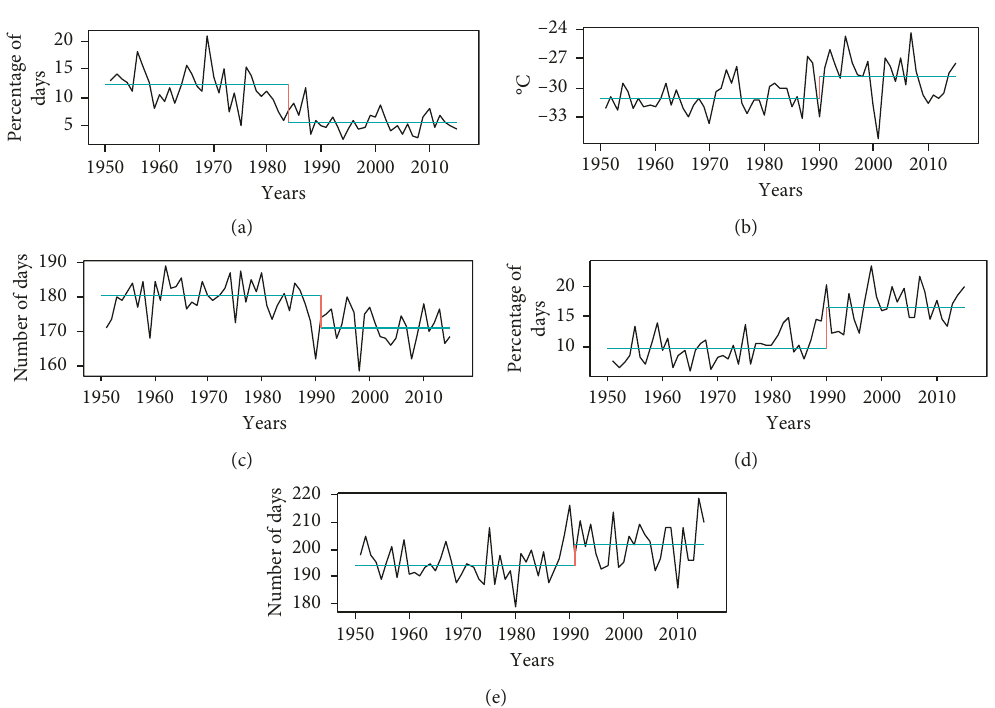
Figure 6: Annual changes of extreme temperature indices in Northeast China. (a) Cold night frequency (TN10p). (b) Annual minimum value of daily minimum temperature (TNn). (c) Frost days (FD). (d) Warm night frequency (TN90p). (e) Growing season length (GSL). The blue line indicates the mean value before and after the changepoint, while red indicates the magnitude of change.